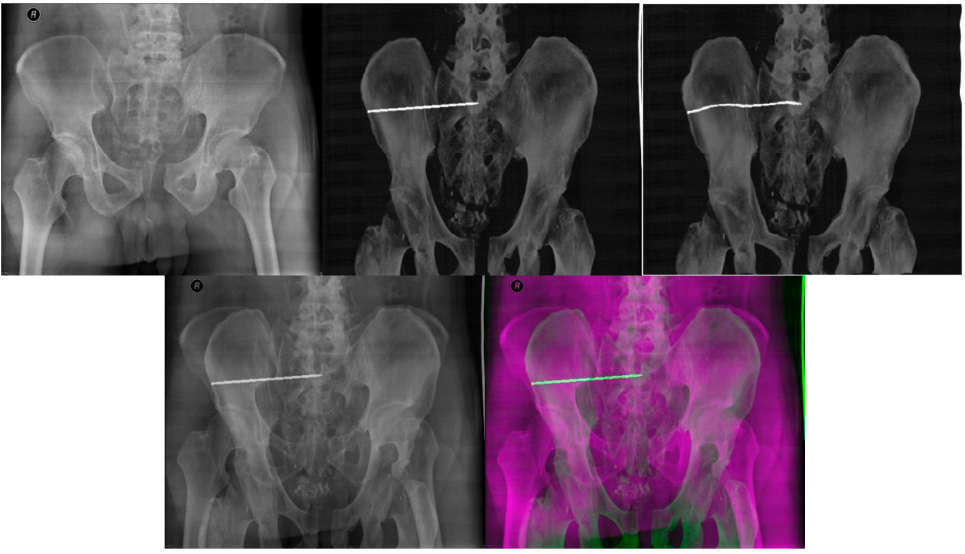
Figure 8. The output of image registration for Patient 1. Left to Right : Reference X-ray image, input DRR projection, output DRR projection, alpha blending composite image and RGB composite im- age.